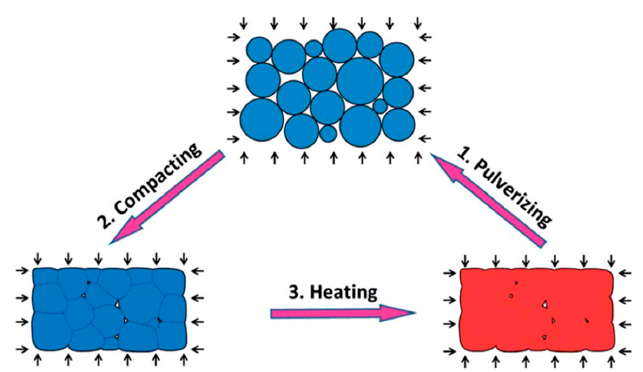
Figure 7. The schematic graphs for a typical reprocessing and recycling routine. ( 1 ) Bulk polymer is firstly pulverized into powders. ( 2 ) The powders were then compacted by applying pressure. ( 3 ) The compacted powder is heated under pressure. Due to the internal bond exchange reaction (BER), the polymer particles are welded, and interfaces are disappeared. This process is repeated several times (reproduced from [110] with permission from Royal Society of Chemistry).